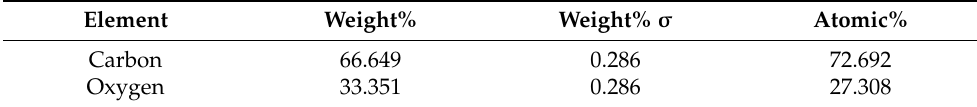
Table 4. Summary if the results of elemental mapping.